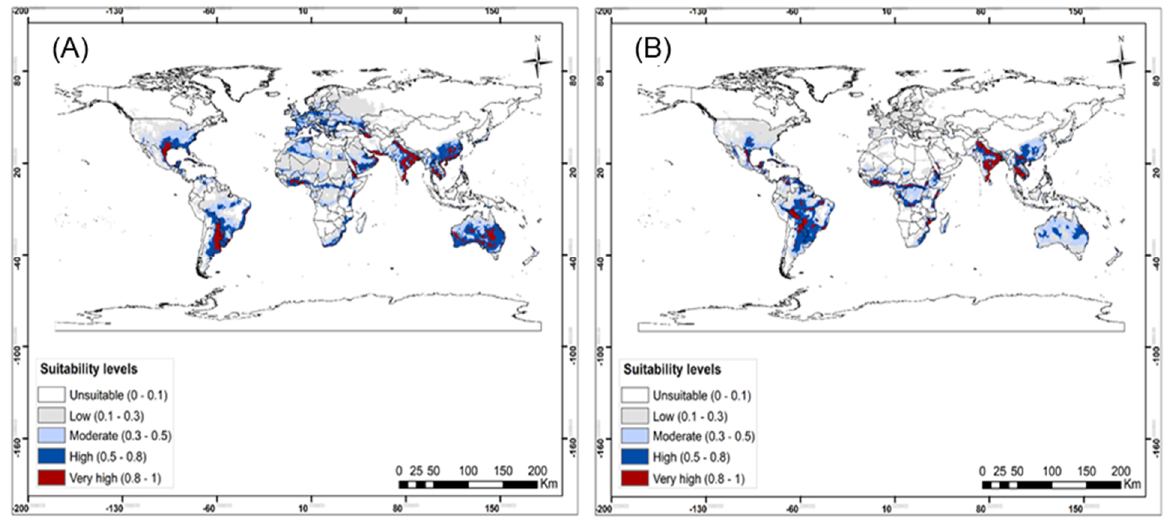
Figure 6. P robable bioclimatic suitability of Stenomesius sp. near japonicus under ( A ) current, and ( B ) representative concentration pathways (RCP2.5) of 2050 climate